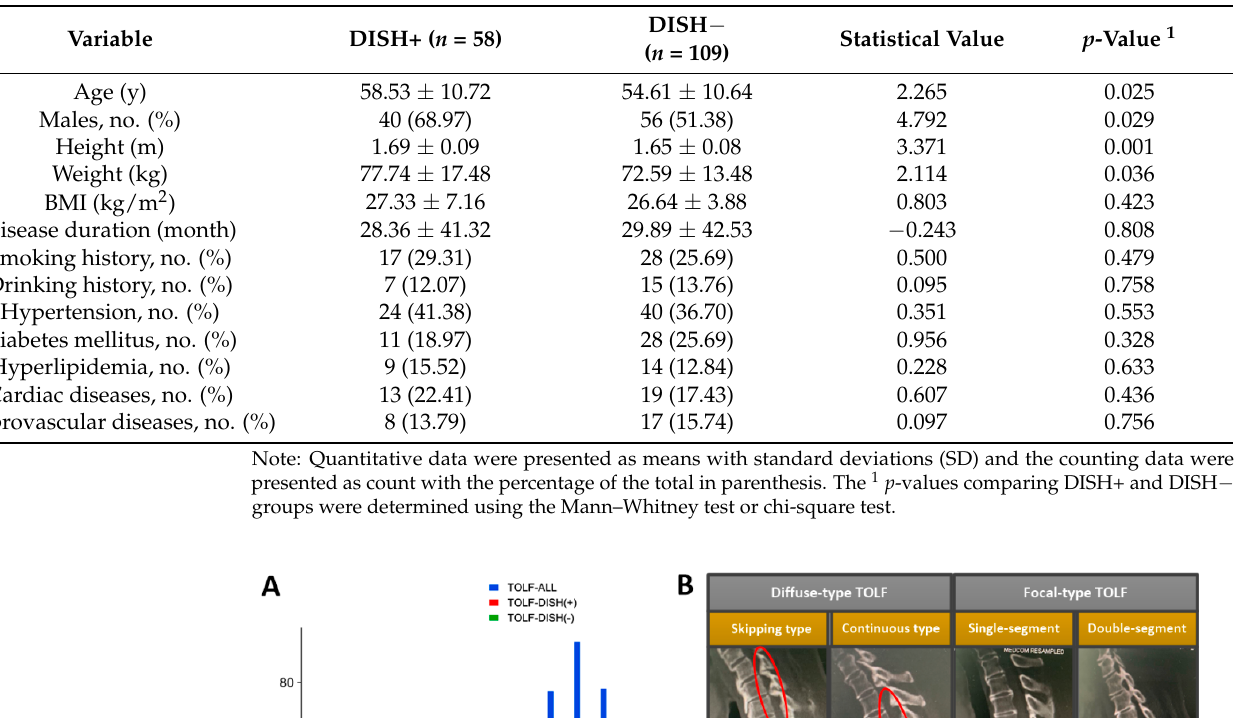
Table 2. Demographic characteristics of patients between the DISH+ and DISH − Group. DISH+ group contains 40 males while DISH − group contains 56 males. DISH+ group contains 40 males while DISH − group contains 56 males. Seventeen patients in DISH+ group has smoking history while 28 patients in DISH − group has smoking history. Seven patients in DISH+ group has drinking history while 15 patients in DISH − group has drinking history. Twenty-four patients in DISH+ group has hypertension while 40 patients in DISH − group has hypertension. Eleven patients in DISH+ group has diabetes mellitus while 28 patients in DISH − group has diabetes mellitus. Nine patients in DISH+ group has hyperlipidemia while 14 patients in DISH − group has hyperlipidemia. Thirteen patients in DISH+ group has cardiac diseases while 19 patients in DISH − group has cardiac diseases. Eight patients in DISH+ group has cerebrovascular diseases while 17 patients in DISH − group has cerebrovascular diseases.